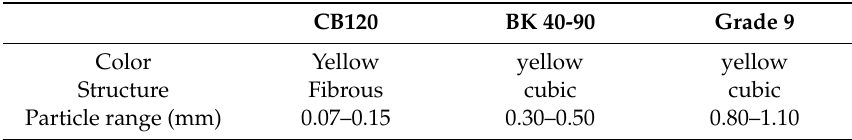
Table 1. Physical properties of Lignocel ®